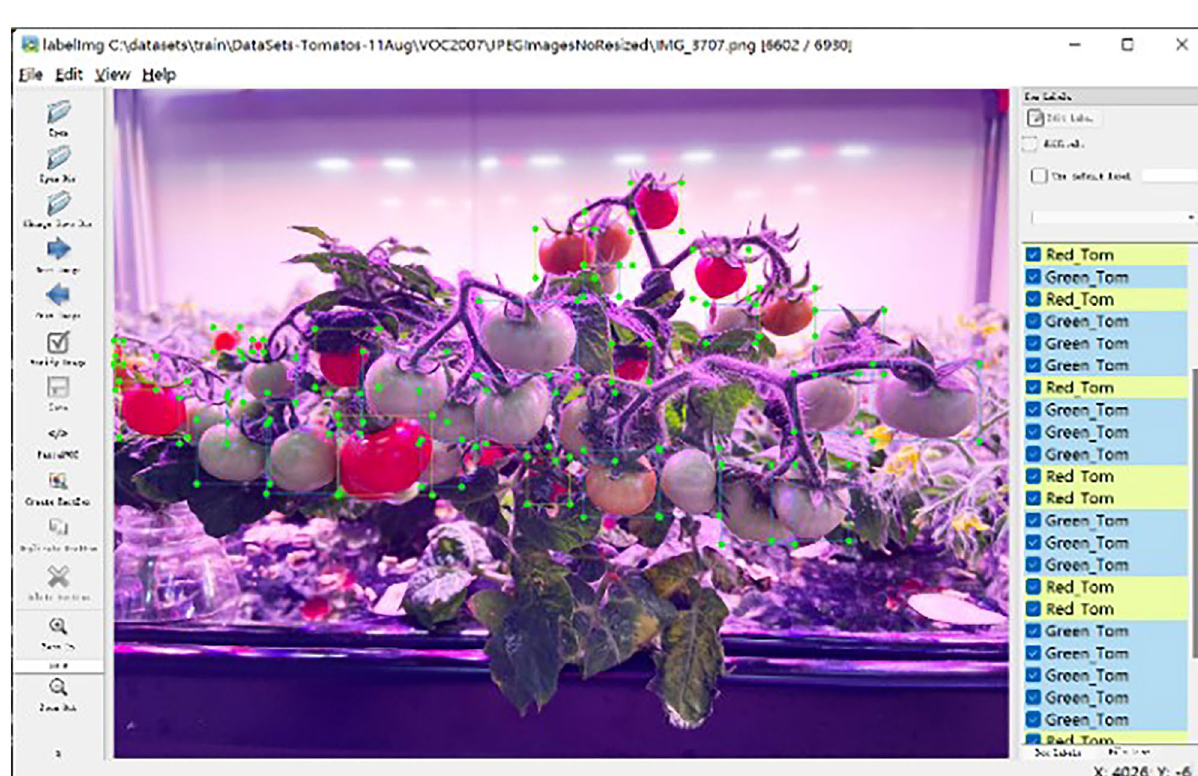
Figure 7. Data annotation